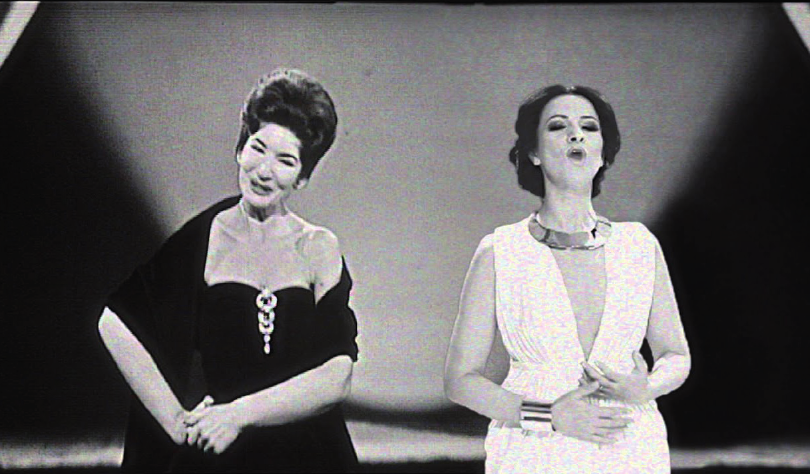
Fig. 2 Still frame from the “Gheorghiu-Callas ‘Habanera’ duet” video (EMI Classics Music Video. © 2011 EMI Records Ltd. All rights